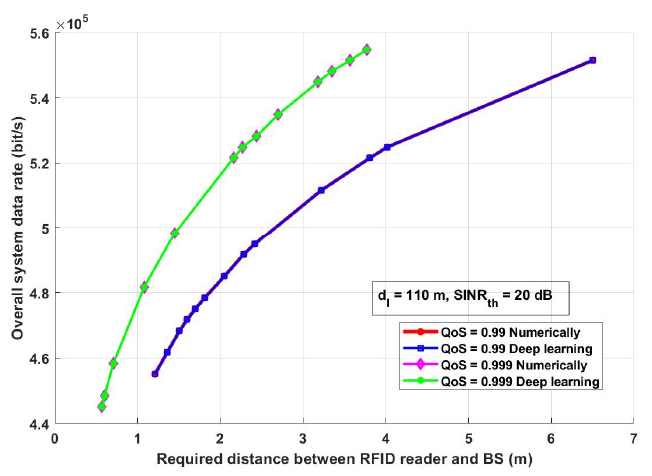
Figure 13. The required distance between an RFID reader and BS (m) versus overall system data rate (bit/s).